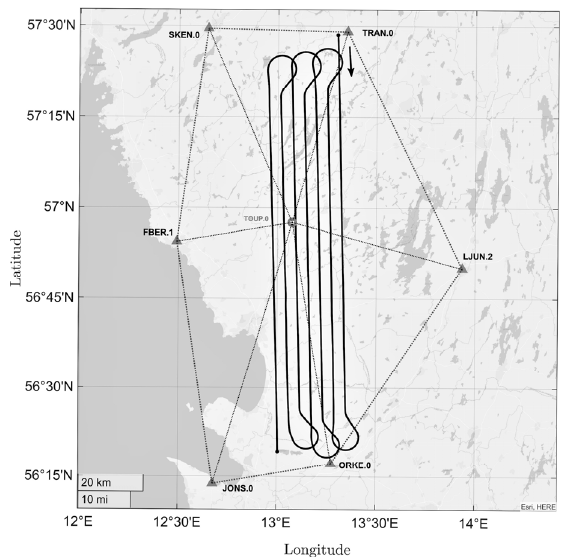
Figure 3. The aircraft trajectory and a configuration of the SWEPOS GNSS reference